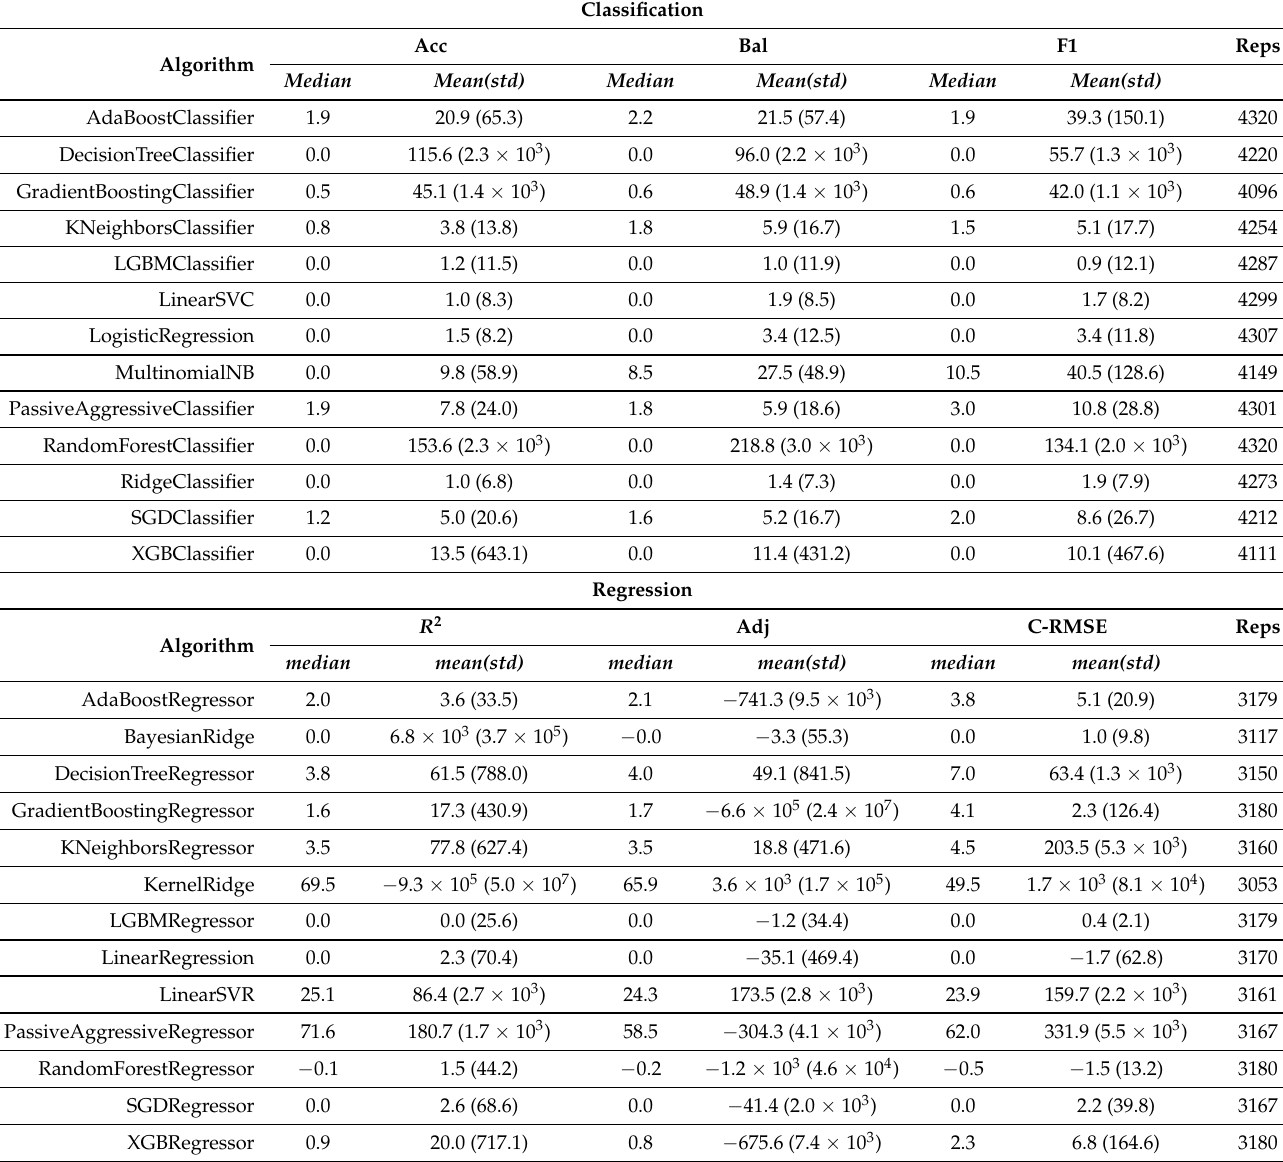
Table 2. Compendium of final results over 26 ML algorithms, 250 datasets, 96,192 replicates, and 28,857,600 algorithm runs. A table row presents results of a single ML algorithm, showing a summary of all replicates and datasets. A table cell summarizes the results of an algorithm–metric pair. Cell values show median and mean(std) , where median : median over all replicates and datasets of Optuna’s percent improvement over default; mean(std) : mean (with standard deviation) over all replicates and datasets of Optuna’s percent improvement over default. The total number of replicates for which these statistics were computed is also shown. Acc: accuracy score; Bal: balanced accuracy score; F1: F1 score; R 2 : R 2 score; Adj R 2 : adjusted R 2 score; C-RMSE: complement RMSE; Reps: